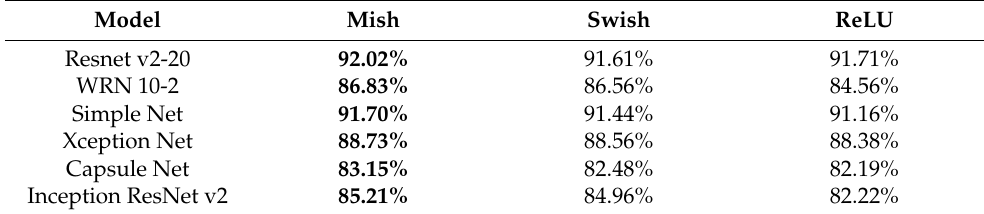
Table 3. Comparison the functions of Mish, Swish, and ReLU [22].